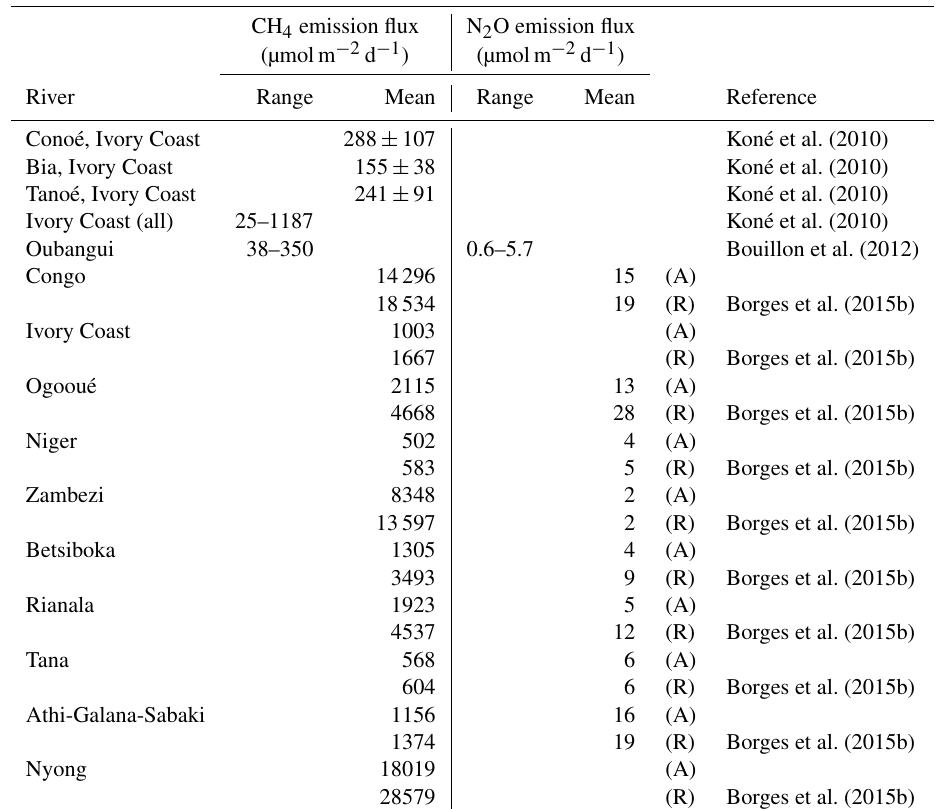
Table 4. Emissions of CH 4 and N 2 O published for African rivers: (A) refers to emissions estimated using the relationship of Aufdenkampe et al. (2011) and (R) refers to emissions estimated using the relationship of Raymond et al.